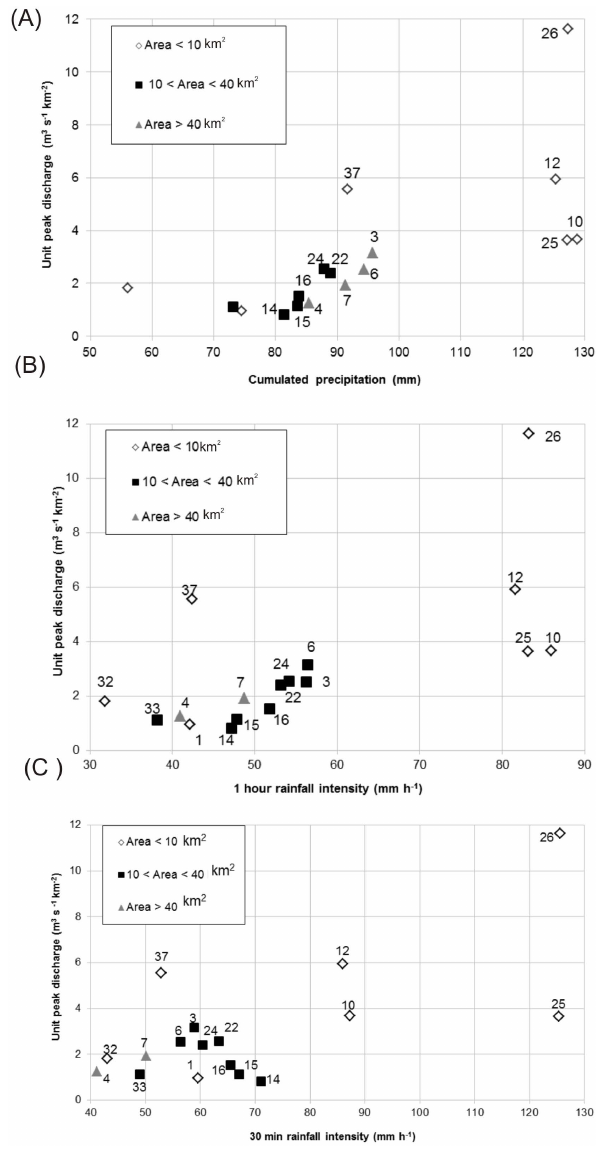
Fig. 8. Relationship between estimated unit peak discharges and rainfall characteristics for the 17 IPEC catchments: (a) event cu- mulated rainfall; (b) max. 1-h rainfall intensity; (c) max. 30-min rainfall intensity. The numbers refer to the basins listed in Table 1.